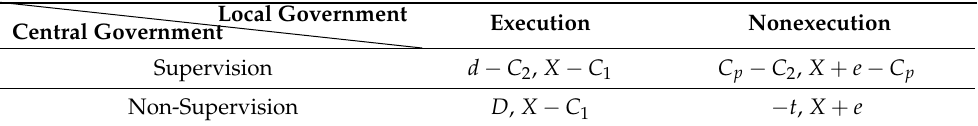
Table 1. The game matrix of the central government and the local government. GovernmentLocal Government Execution Nonexecution Central Supervision